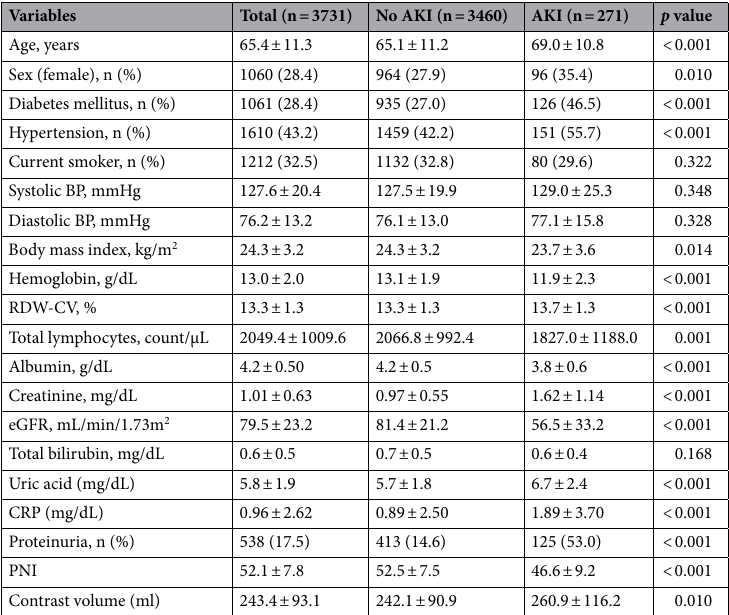
Table 1. Clinical characteristics of subjects between no AKI and AKI. AKI acute kidney injury, BP blood pressure, RDW-CV red cell distribution width coefficient of variation, eGFR estimated glomerular filtration rate, CRP C-reactive protein, PNI prognostic nutritional